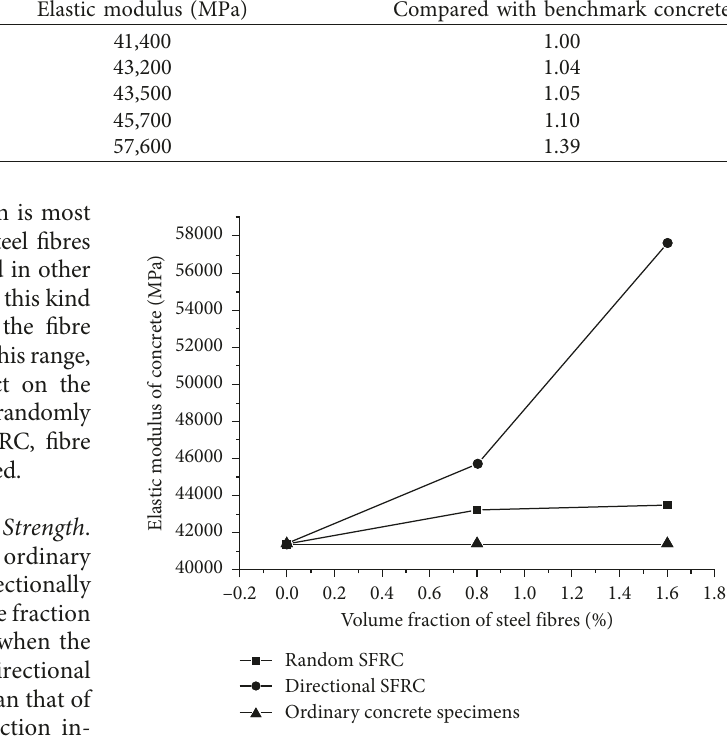
Figure 9: Elastic modulus of concrete with different fibre volume